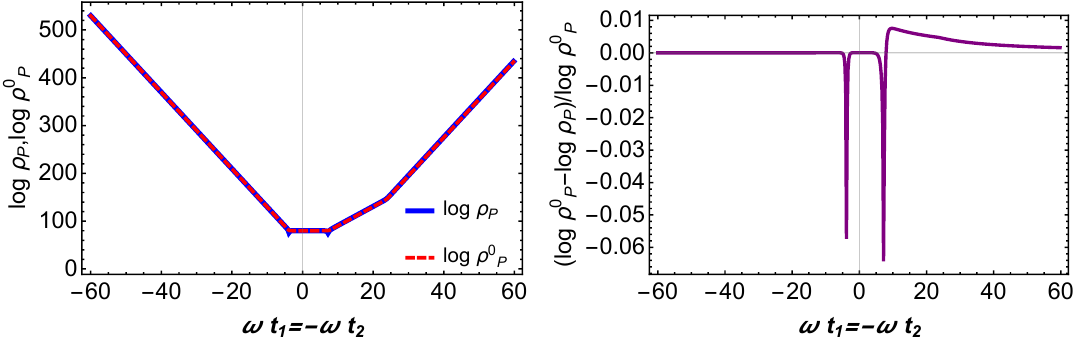
− log ρ ) / log ρ 0 P P P